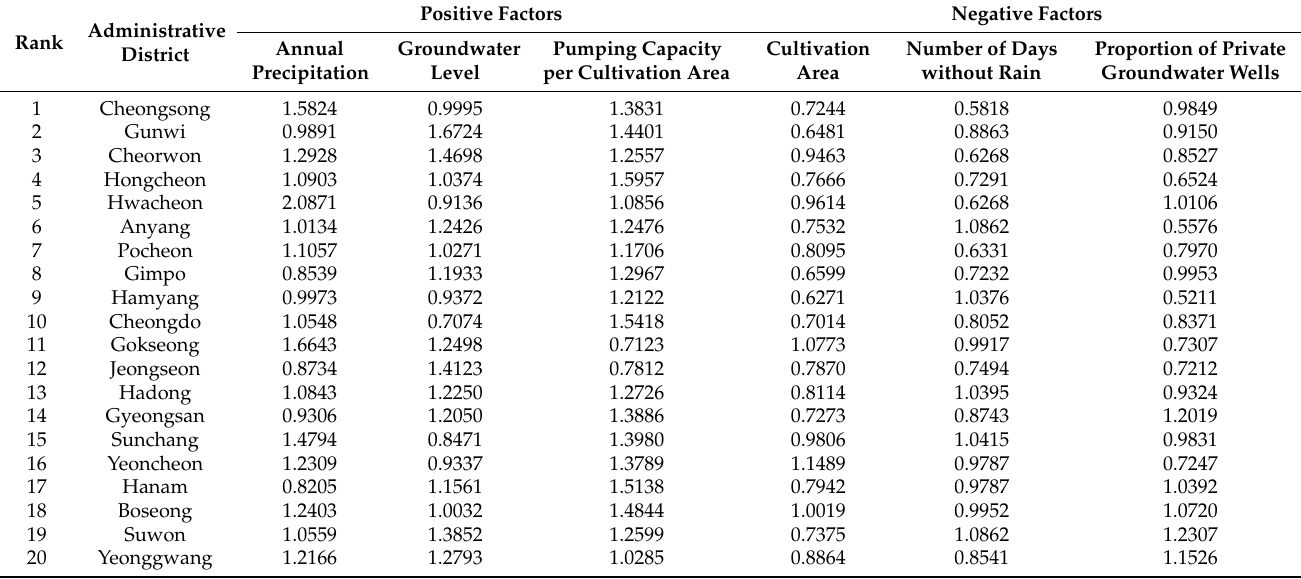
Table 4. Ranking of the 20 most vulnerable districts.